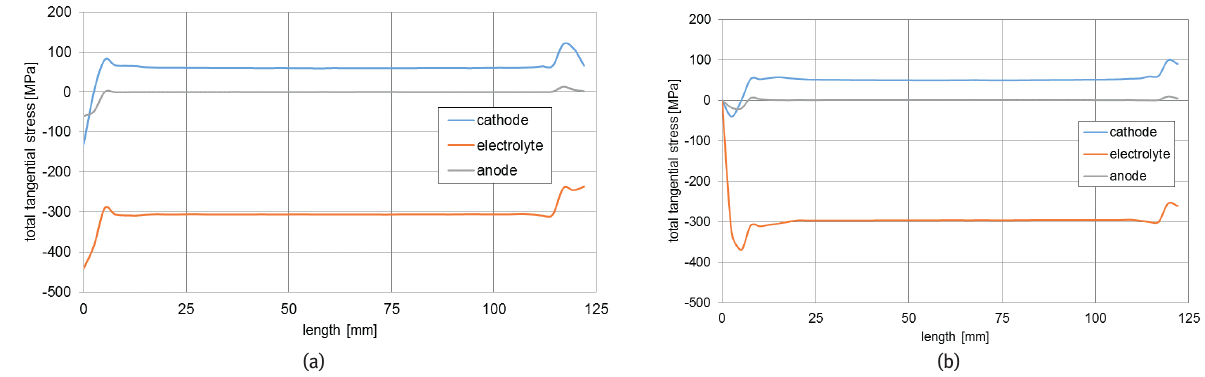
Figure 18: Distribution of total tangential stress of the mSOFC stack with supporting structure along the horizontal centerlines of each layer: